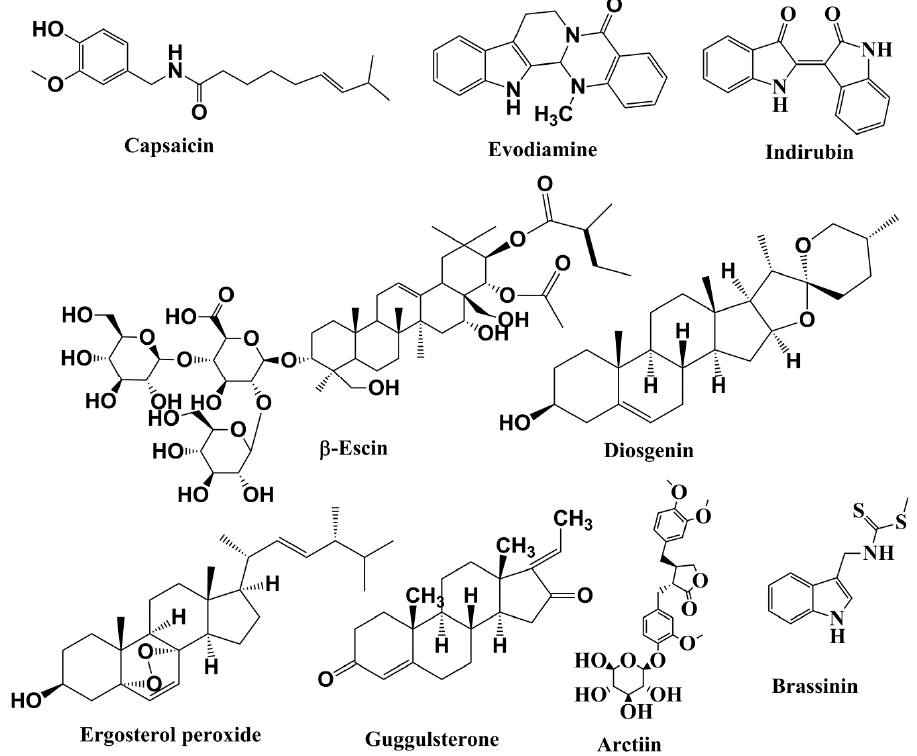
Figure 4. Structures of alkaloids, saponins, and steroids involved in anticancer activities related to inhibition of the JAK/STAT pathway.